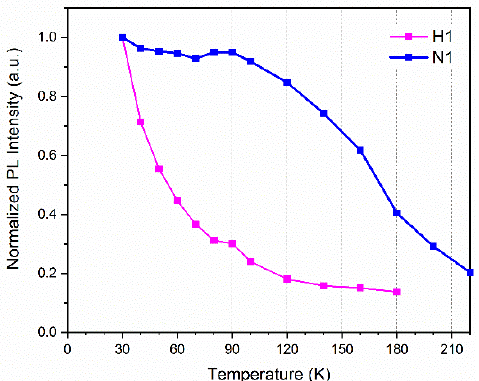
Figure 3. Normalized PL integral intensity as a function of temperature, ranging from 30 K to 220 K. The intensity of sample H1 is only displayed below 180 K because the luminescence intensity at higher temperatures reduces too much to become almost indistinguishable.